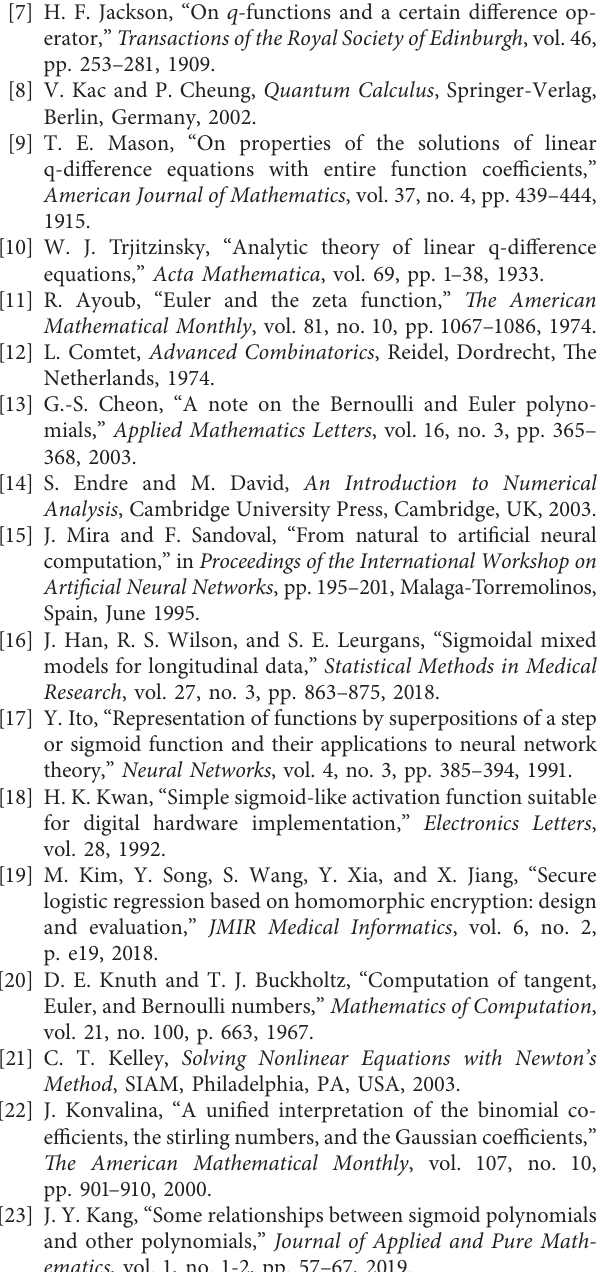
( x ) for q � 0 . 1 , 0 . 5 , 0 . 9, 1 ≤ n ≤ n,q